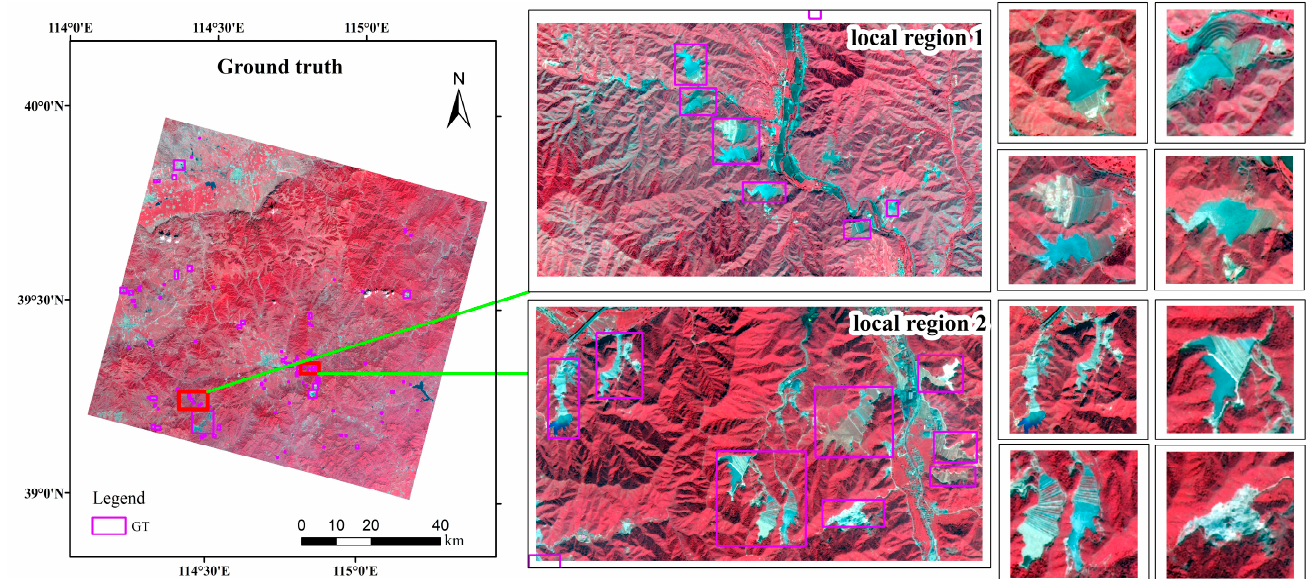
Figure 13. Ground truth on the entire GF-6 images.